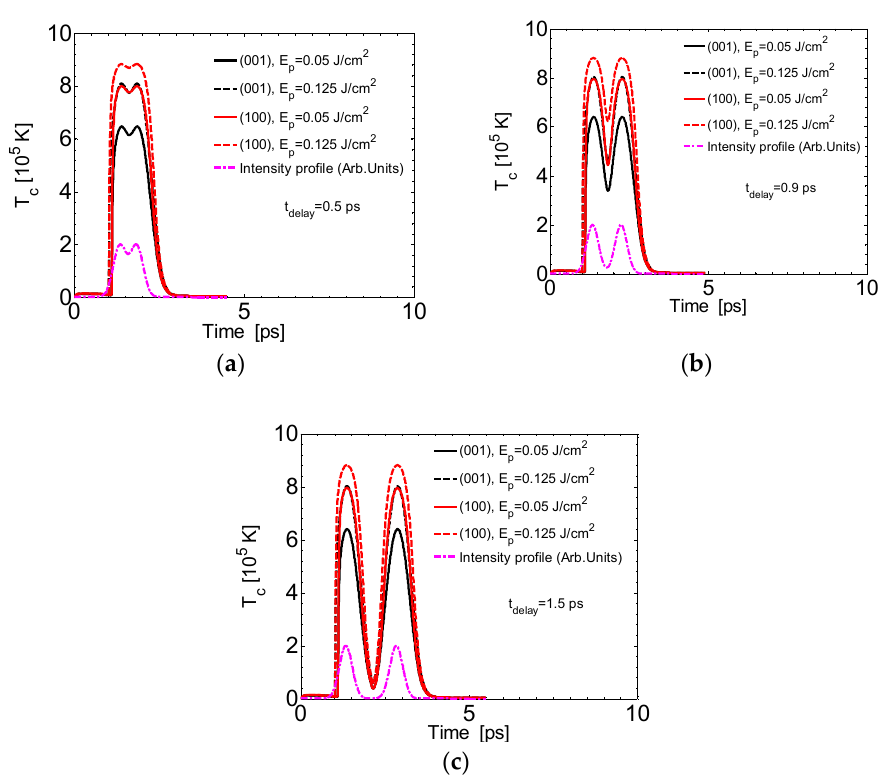
Figure 4. Evolution of reflectivity for E p = 50 mJ/cm 2 and 125 mJ/cm 2 for (001) and (100) crystal orientation at t delay = 0.5 ps ( a ), 0.9 ps ( b ), and 1.5 ps ( c ).